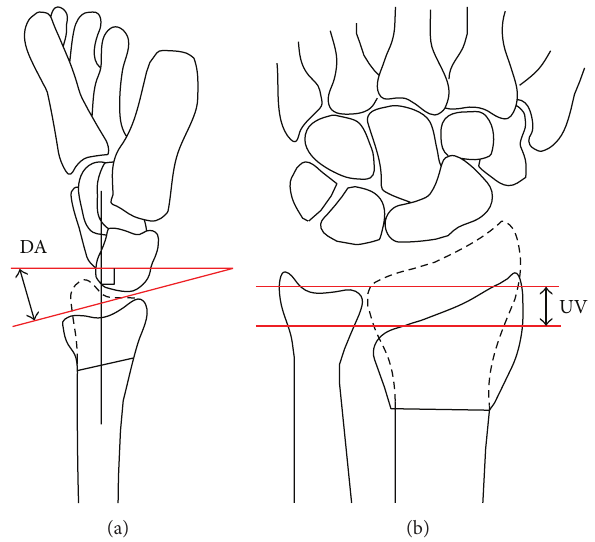
Figure 1: The measurement of dorsal angle (DA) and ulnar variance (UV). These measurements were expressed as a negative for volar angulation and a positive for DA and a positive value for UV if there was radial